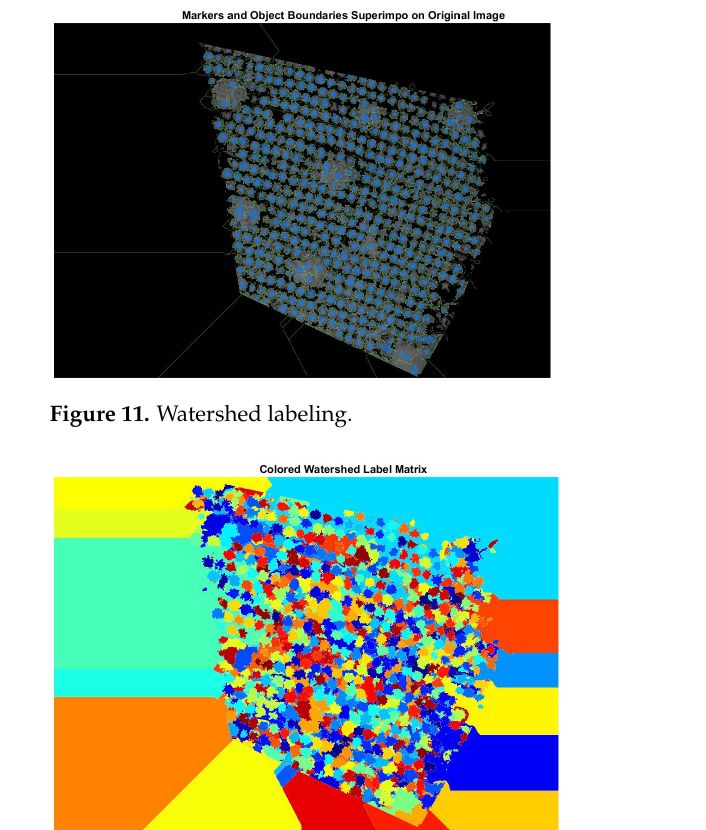
Figure 12. Watershed results: display all detected labels in a different color by applying a LUT color